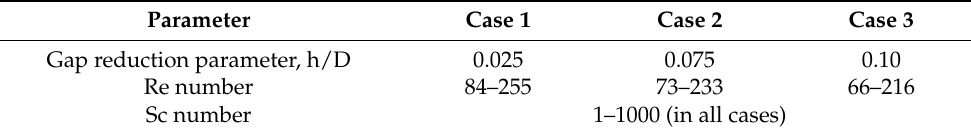
Table 1. Conditions for performed simulation cases. Spacer geometry: L/D = 12, β = 105 ◦ .